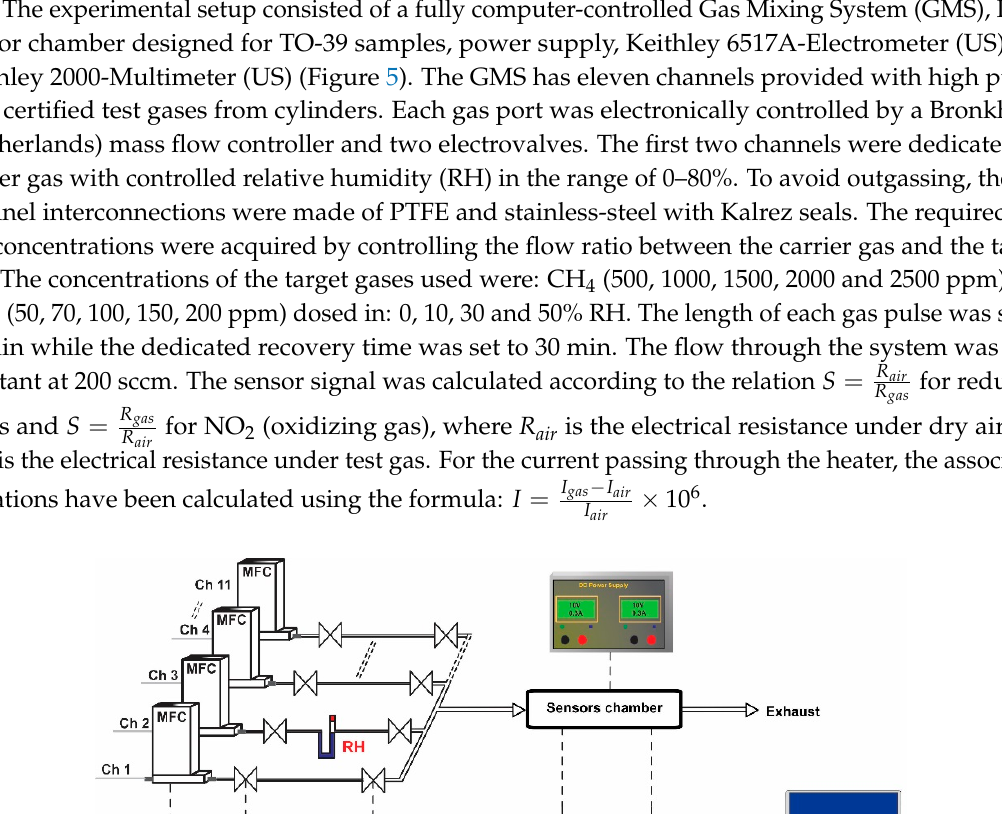
Figure 7. AFM Images of ( a ) 10 nm and ( b ) 50 nm TiO 2 films deposited at 200 °C.